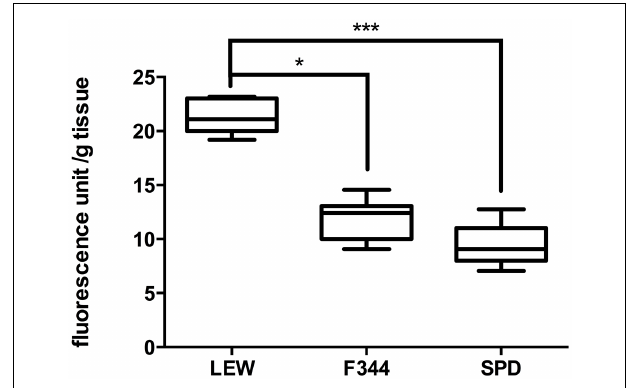
represent the distribution of the data ( n = 8/group), extending from the 25th to the 75th percentiles; the line is drawn at the median; whiskers represent the highest and lowest values. * P < 0.05; *** P < 0.001. Kruskal–Wallis test with a post hoc Dunn’s multiple comparisons